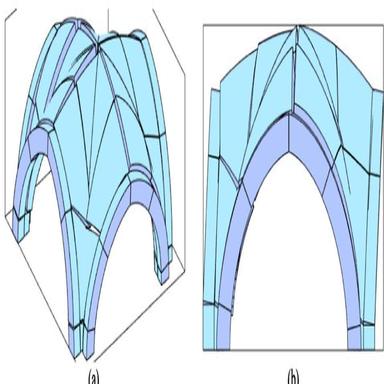
Collapse mechanism for the FRP-reinforced vault found with adaptive NURBS limit analysis. (a) Perspective and (b) lateral views.